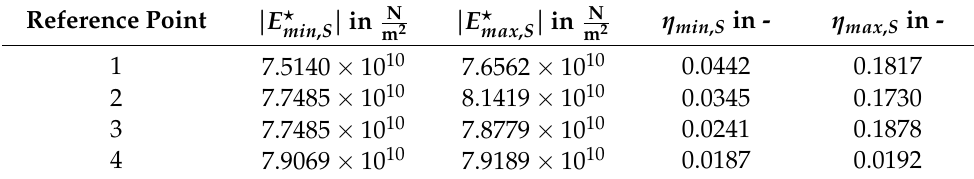
Table 5. Limit values after the surrogate modeling